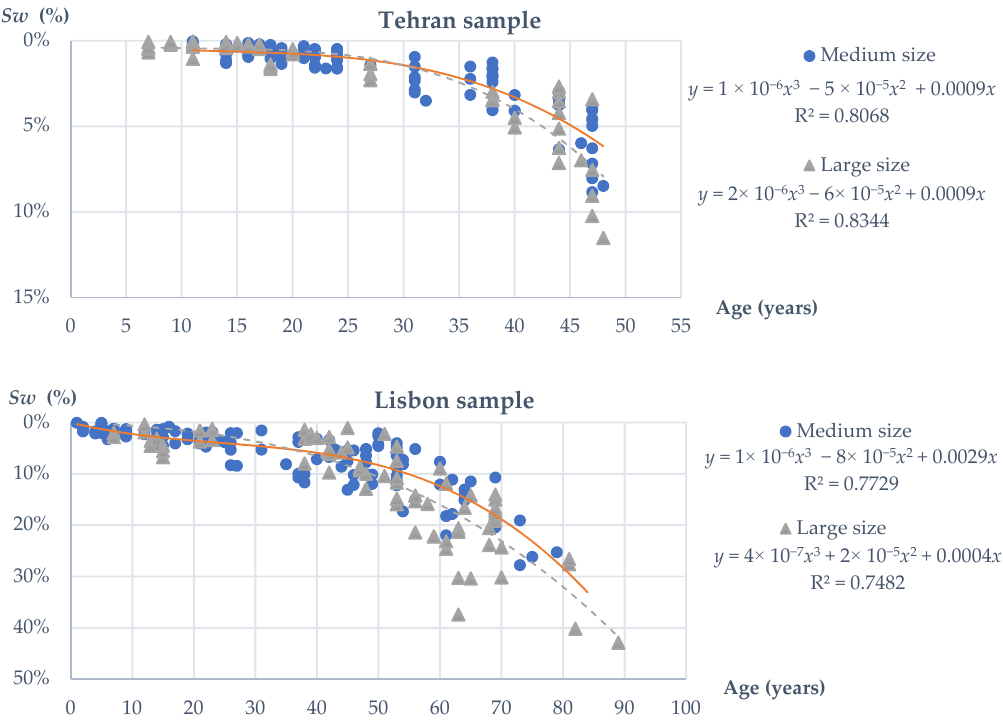
Figure 12. Degradation curves of the Tehran and Lisbon samples, according to the size of the stone elements. In terms of the location of the cladding (Figure 13), the samples under analysis were grouped depending on whether the stone cladding was located in the taller areas of the façade (integral or partial elevated cladding) or only in the lower floors of the building (partial bottom cladding).